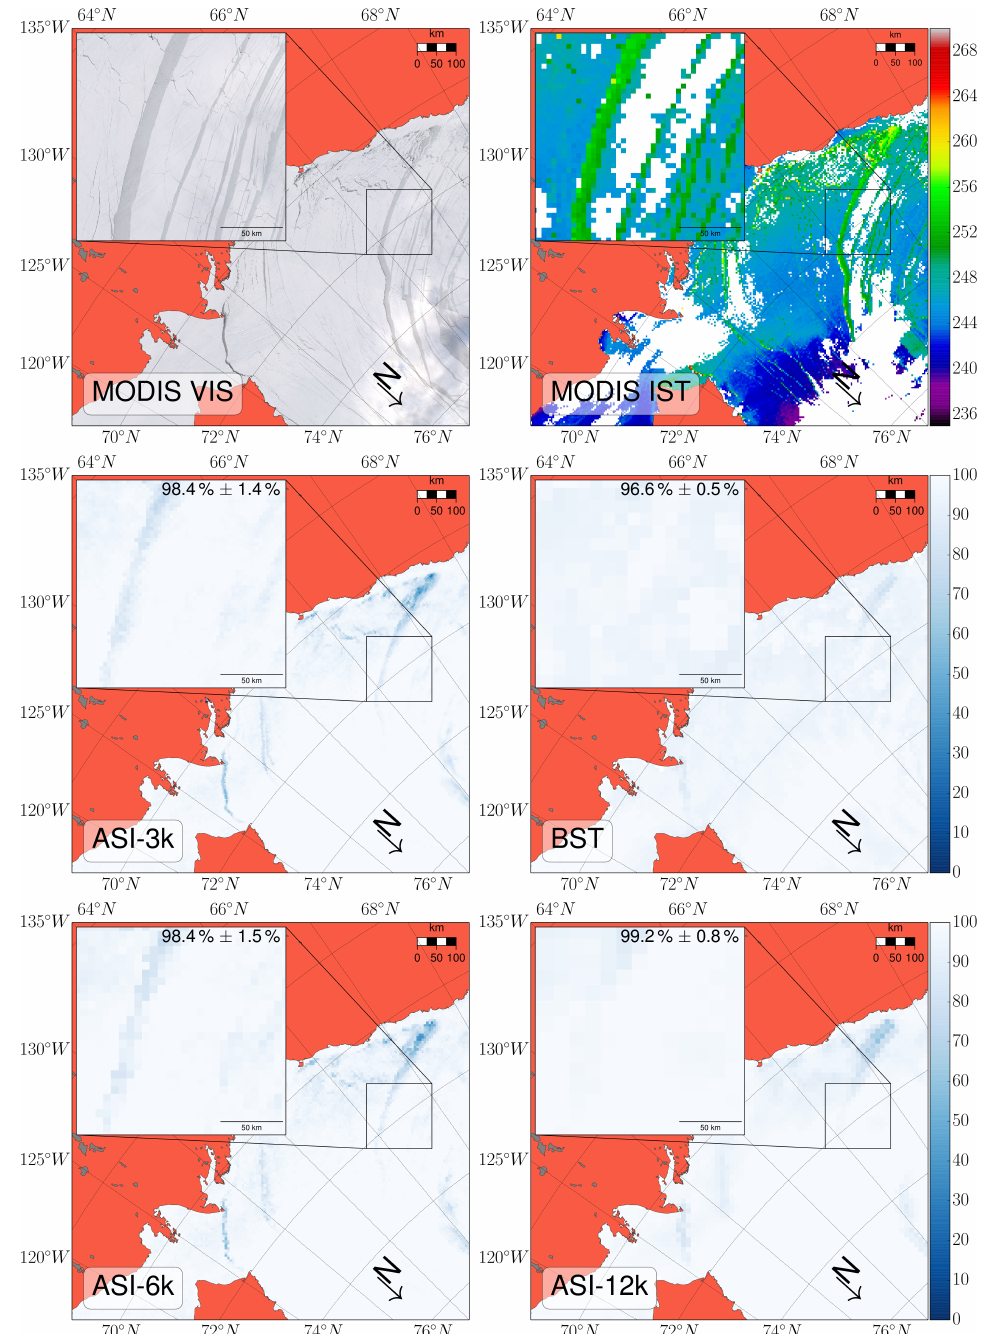
Figure 3. Comparison of 250-m MODIS True Color (MODIS VIS), 4-km MODIS ice surface temperature (MODIS IST), ASI-3k, ASI-6k, ASI-12k and Bootstrap (BST) sea ice concentrations (SIC) for 27 February 2013. All maps display a part of the southern Beaufort Sea, with the Canadian and Alaskan coasts in the upper and left parts of the maps. The northern tip of Banks Island can be seen at the lower margin of the maps. An image inset with a zoom of a specified region (170 km × 170 km ) is placed on the continental areas for a closer examination of the individual data sets. An arrow depicts the direction to the North Pole. The white areas in MODIS IST depict missing